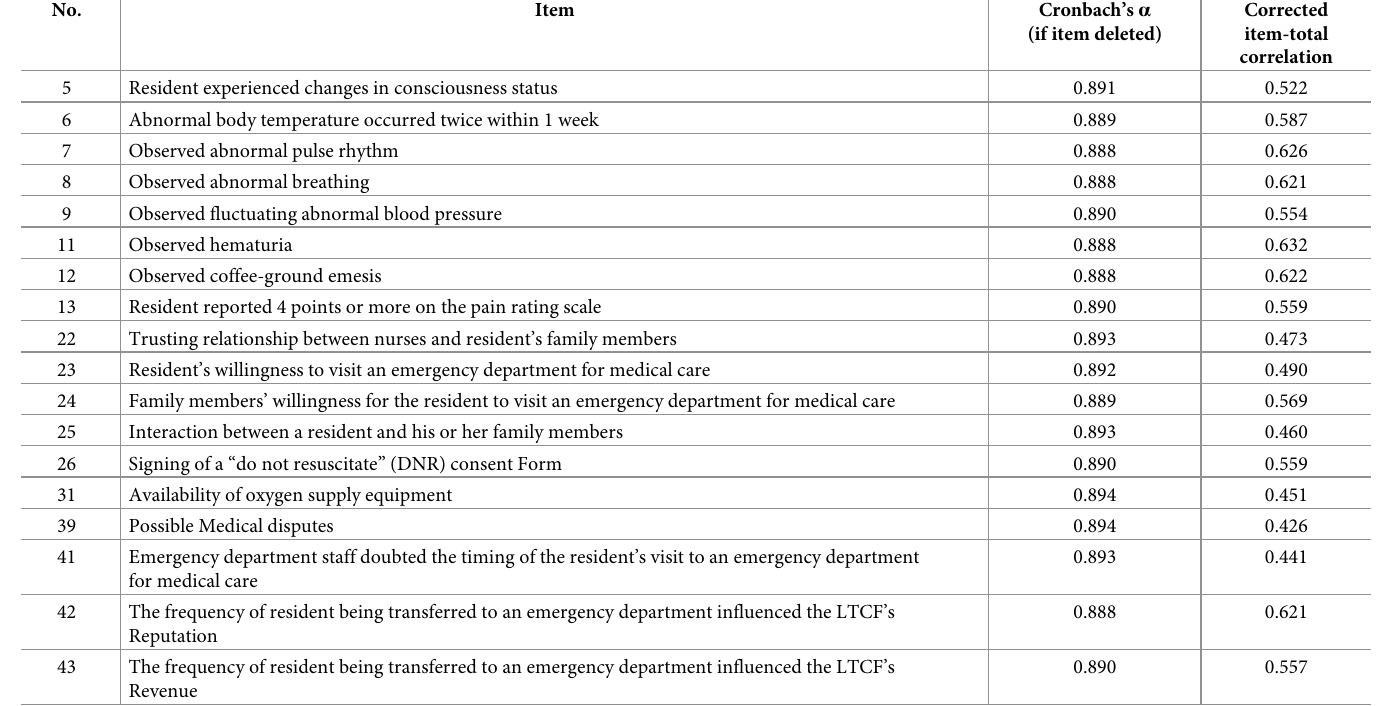
Table 3. 18 Item characteristics of internal consistency ( N =